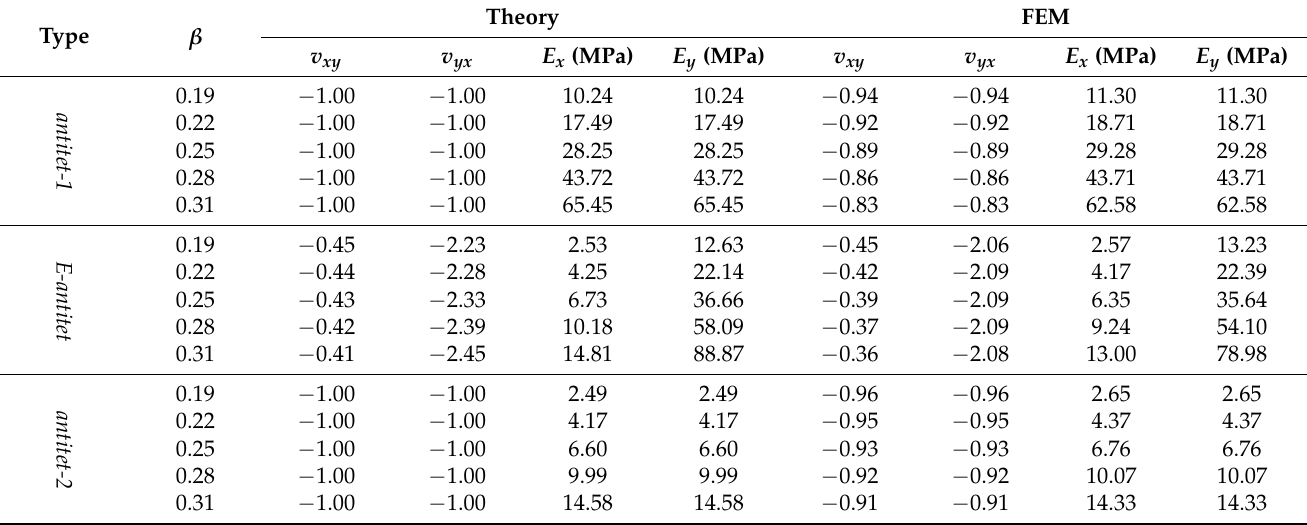
Table A5. Detailed results of Poisson’s ratio and Young’s modulus of E-antitet at different β .